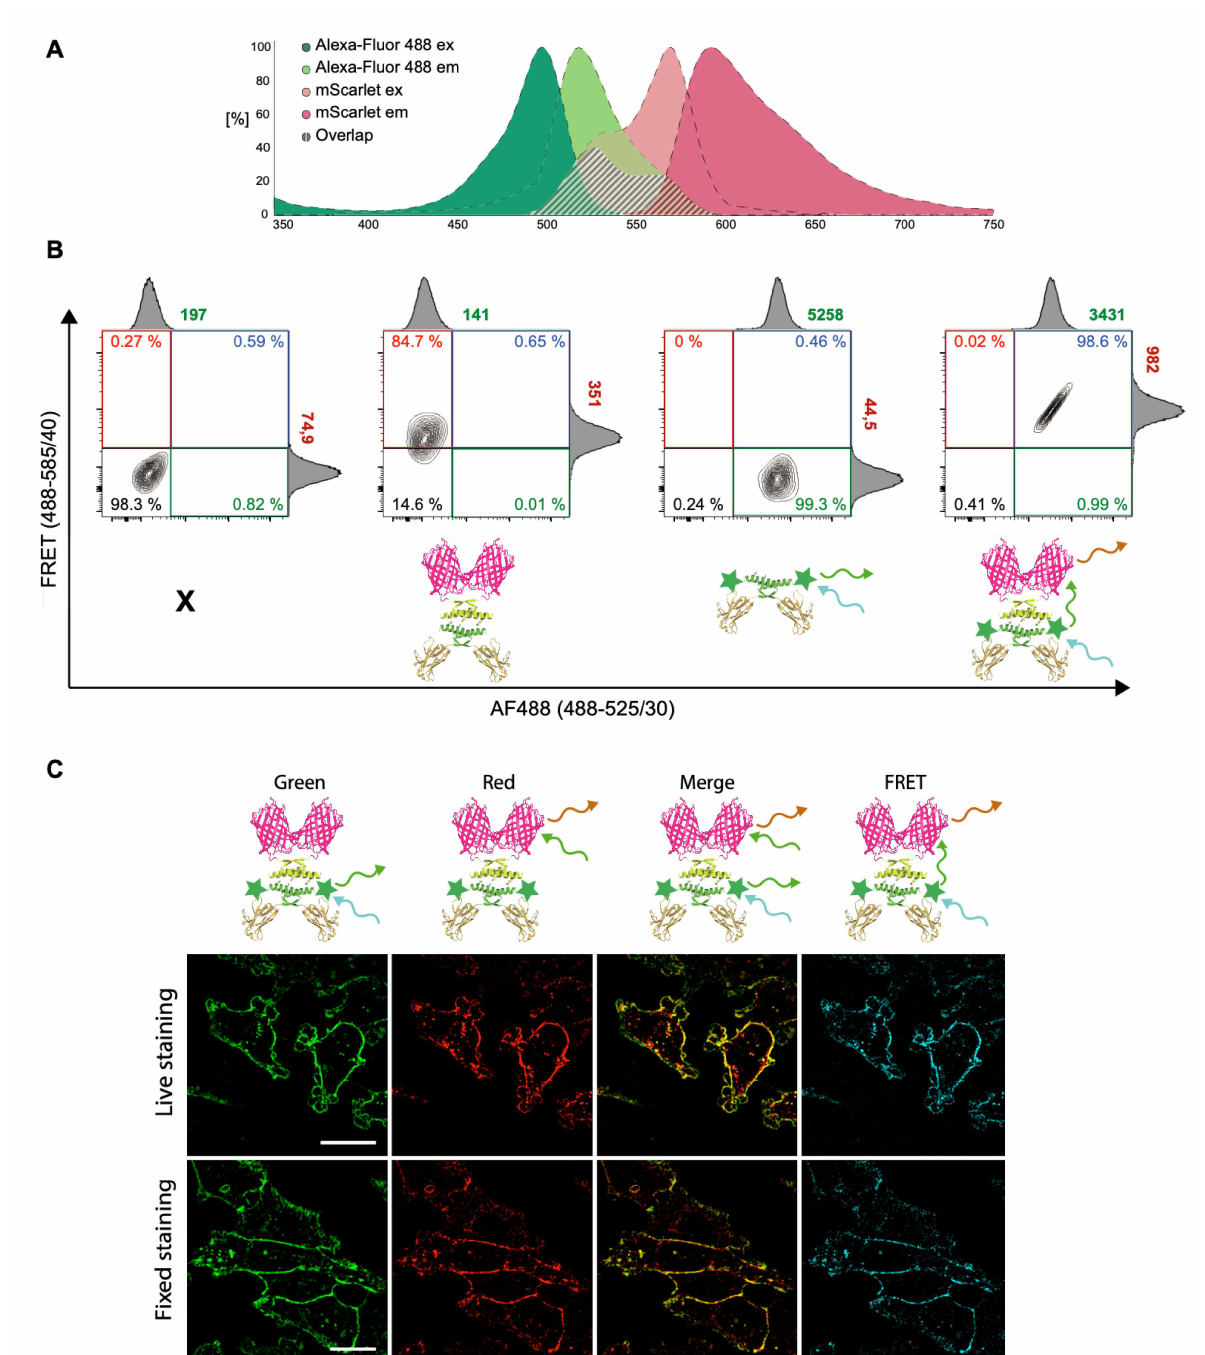
Figure 3. FRET between nano-HER2-E3-C-488 and mScarlet-K3 visualized by flow cytometry and by confocal microscopy. ( A ) Representation of the pair of chosen fluorophores and their respective spectra as indicated. ( B ) HCC1954 cells were incubated with the indicated complexes and analyzed by flow cytometry following excitation with a 488 nm laser. ( C ) Living fixed HCC1954 cells were incubated with the different complexes. Images were taken by confocal microscopy and analyzed with Image J. Cartoons represent the complexes. Scale bar represents 10 µ m. Representative results of three independent